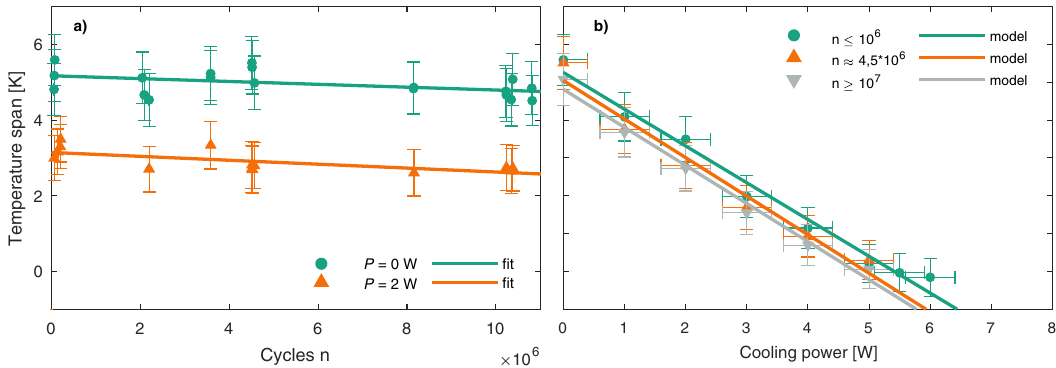
Fig. 3 Long-term stability of the active elastocaloric heat pipe (AEH). a The temperature span versus the number of cycles n at a frequency of 0.8 Hz is plotted in green with zero and in orange with 2 W of heating load at the evaporator. The data are in agreement with a linear for the entire measurement series (lines). The linear fi t for the maximum temperature span Δ T is Δ T ¼ 5 : 2K (cid:2) n (cid:3) 3 : 8 (cid:3) 10 (cid:2) 8 K, for 2 W it is Δ T ¼ 3 : 1K (cid:2) n (cid:3) 5 : 2 (cid:3) 10 (cid:2) 8 K. Error bars as calculated as described in the methods. b Measurement of the temperature span at different heat loads at a frequency of 0.8 Hz. The data points at the beginning of the long-term measurement are shown in green, after 4.5 × 10 6 cycles in orange and after more than 10 7 cycles in grey. The linear fi t is expected 41 . The calculation of the errors is given in the methods.